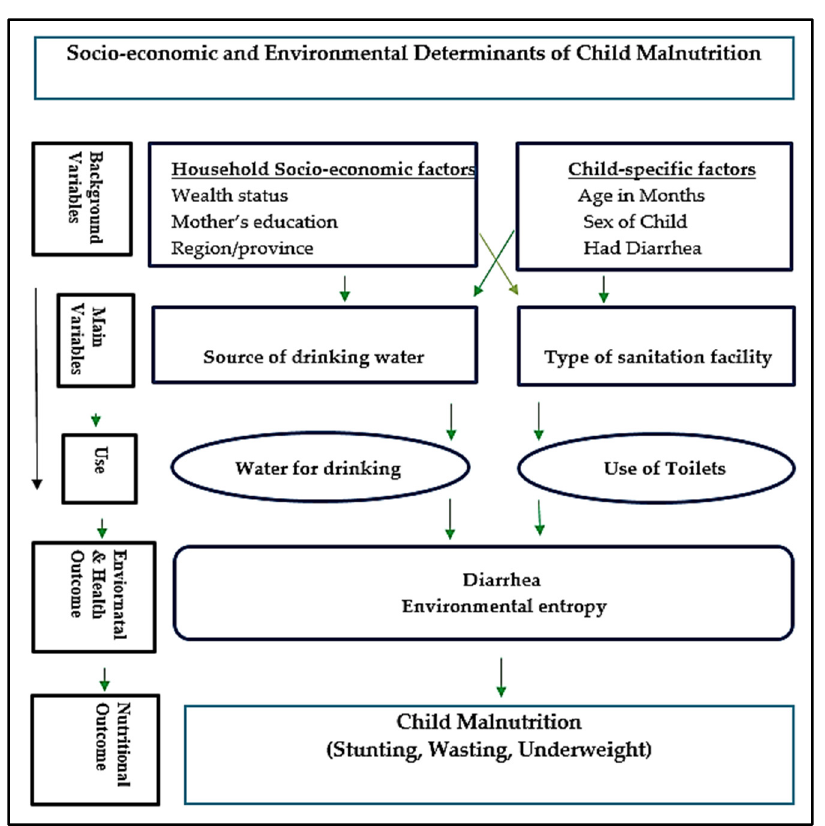
Figure 1. The conceptual relationship between the explanatory variables of the study and child growth status. growth